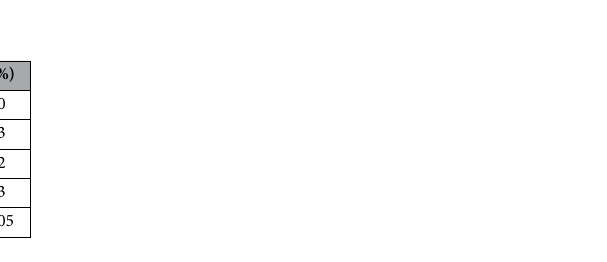
Table 2. Percentage of outlier 3°–7° differed from projected TEA. n.s. non-significant.